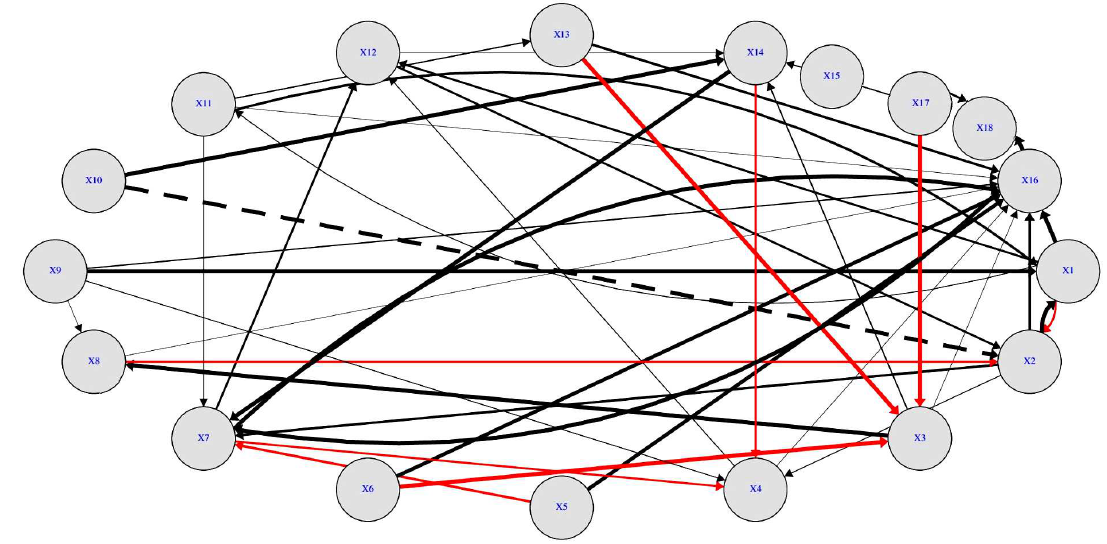
Figure 3. Cognitive map of multilevel transfer of innovations in